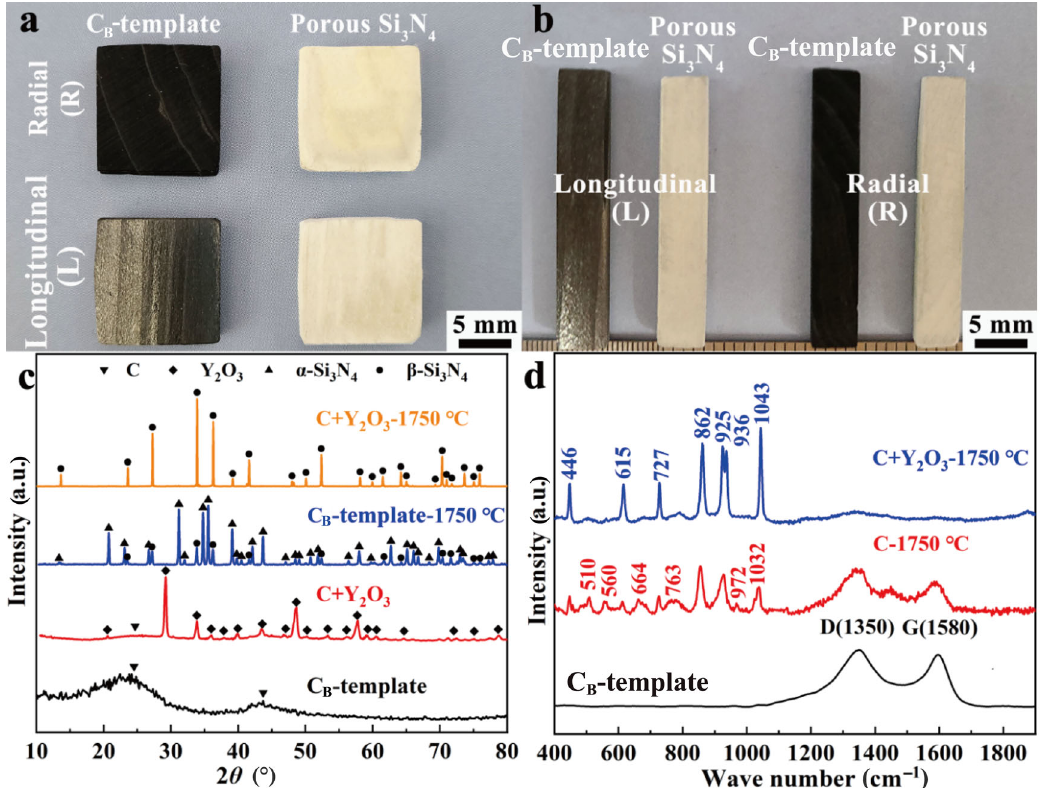
Fig. 1 (a, b) Optical photographs, (c) X-ray diffraction (XRD) patterns, and (d) Raman spectra of C B -template pyrolyzed at 1000 ℃ for 4 h, and bio-Si 3 N 4 sintered at 1750 ℃ for 4 h. At radial (R) orientation, the lumina in wood are perpendicular to the plane axial, and at longitudinal (L) orientation, the lumina are along the plane